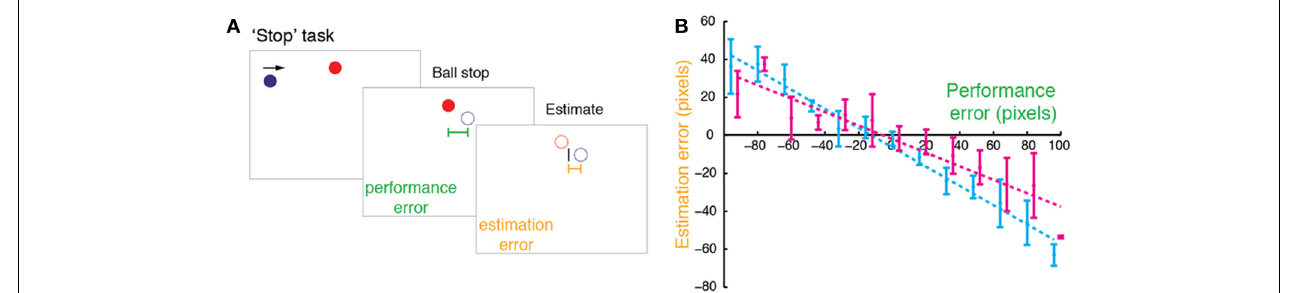
FIGURE 1 | “Stop” task in Experiment 1. (A) In the Stop task, participants were asked to stop a moving blue ball when it was aligned with a stationary red target (Self condition) or watch the computer stopping the ball (Agent condition). After the ball was stopped, it vanished, and participants used a cursor to indicate the stopping point.